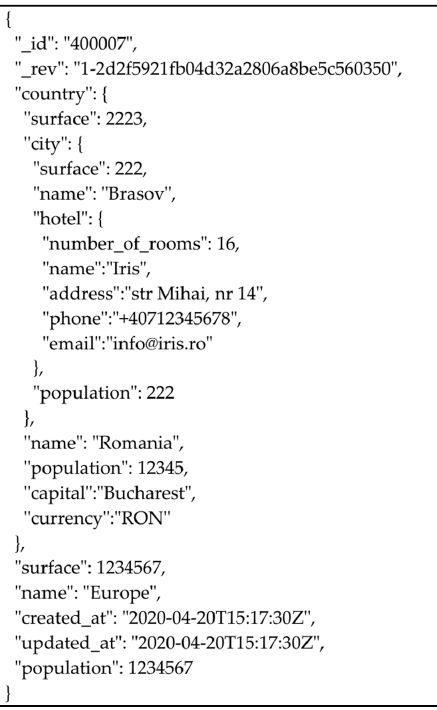
Figure 3. CouchDB's second structure. Figure 3. CouchDB’s second